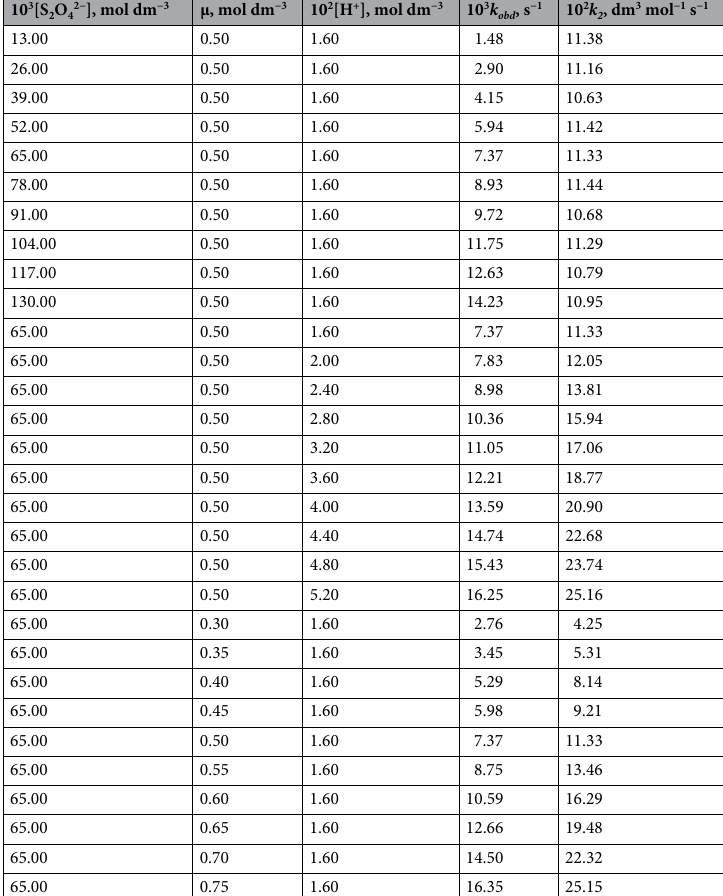
Table 1. Kinetics constants for the reduction of [Mo IV O 2 (paoH) 2 ] 2− by S 2 O 4 2− .